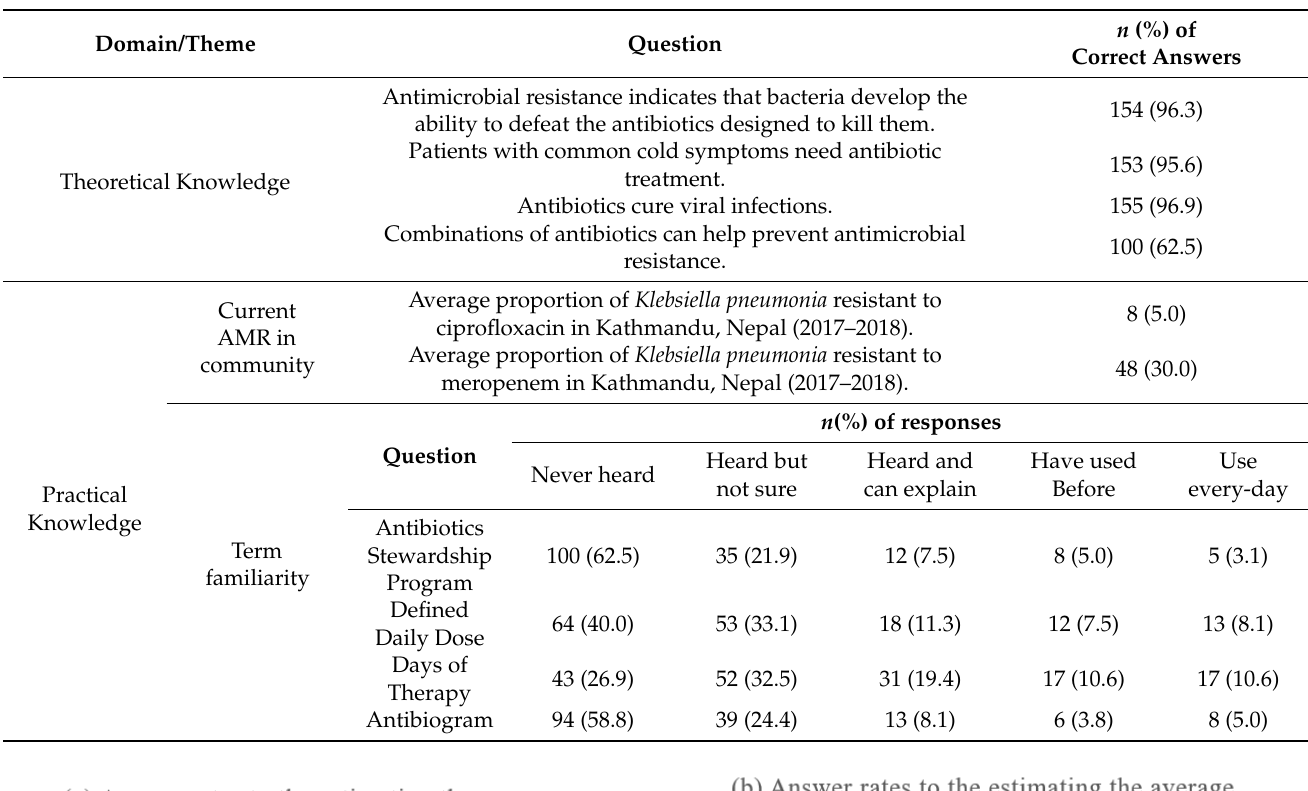
Table 3. Results of the knowledge test ( n = 160).